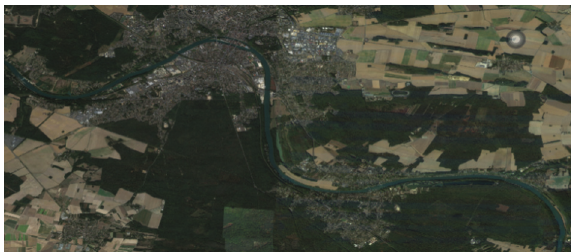
Figure 1: Satellite map of Seine River in France.